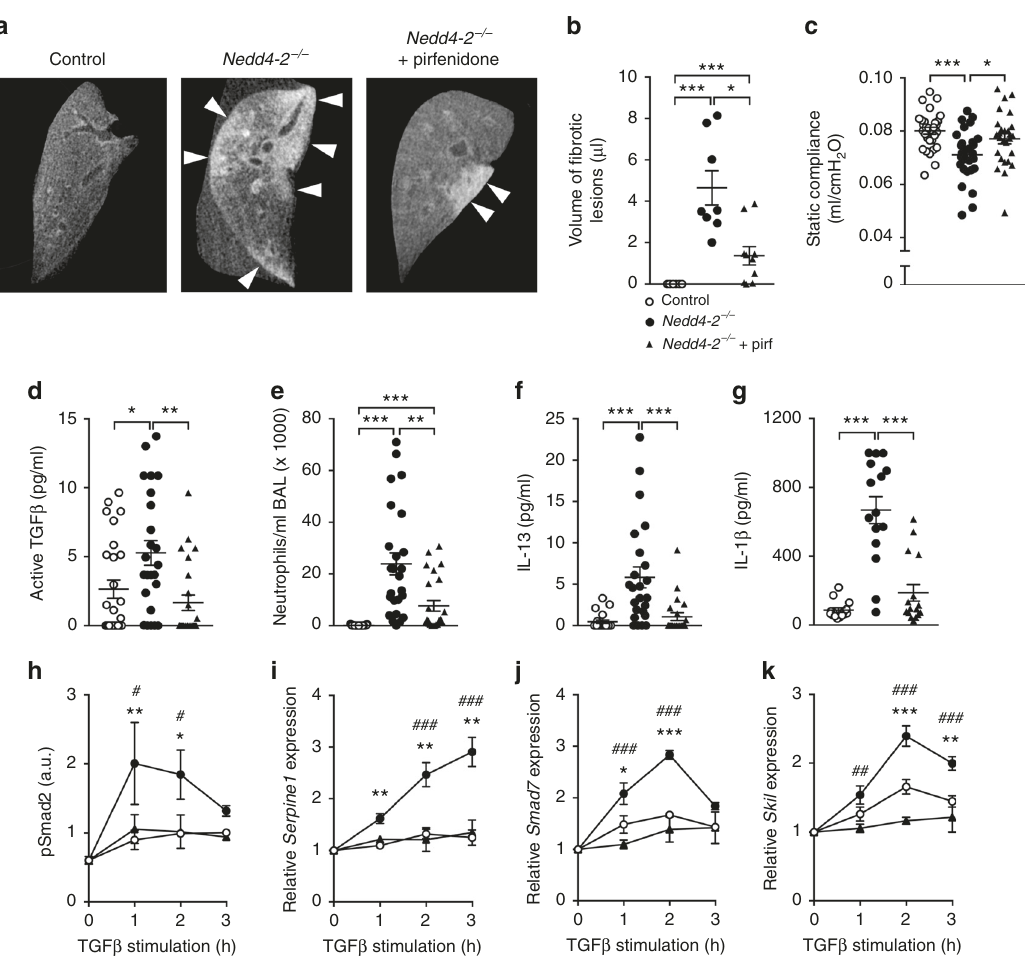
Fig. 8 Pirfenidone treatment reduces pulmonary fi brosis and in fl ammation in conditional Nedd4-2 − / − mice. a Representative micro-CT images of paraf fi n embedded lungs of 3-months doxycycline-induced conditional Nedd4-2 − / − and control mice treated with pirfenidone (pirf) or vehicle alone for one month. Fibrotic areas show patches of increased tissue density (white arrowheads) (control, n = 8; conditional Nedd4-2 − / − , n = 8; conditional Nedd4-2 − / − + pirf, n = 10). b Volumetric analysis of fi brotic regions in the three experimental groups (control, n = 8; conditional Nedd4-2 − / − , n = 8; conditional Nedd4- 2 − / − + pirf, n = 10). c , d Effect of pirfenidone treatment on static compliance (control, n = 30; conditional Nedd4-2 − / − , n = 28; conditional Nedd4-2 − / − + pirf, n = 27) ( c ) and on concentrations of active TGF β in lung homogenates (control, n = 27; conditional Nedd4-2 − / − , n = 24; conditional Nedd4-2 − / − + pirf, n = 24) ( d ). e – g Number of neutrophils (control, n = 29; conditional Nedd4-2 − / − , n = 25; conditional Nedd4-2 − / − + pirf, n = 25) ( e ) and concentration of IL-13 in bronchoalveolar lavage fl uid (control, n = 21; conditional Nedd4-2 − / − , n = 24; conditional Nedd4-2 − / − + pirf, n = 22) ( f ), and concentration of IL-1 β in lung homogenates (control, n = 15; conditional Nedd4-2 − / − , n = 15; conditional Nedd4-2 − / − + pirf, n = 16) ( g ) of conditional Nedd4-2 − / − and control mice treated with pirfenidone or vehicle alone. * P < 0.05, ** P < 0.01, *** P < 0.001. h – k Effect of pirfenidone on TGF β signaling in alveolar type 2 cells isolated from conditional Nedd4-2 − / − and control mice induced with doxycycline for 2 weeks that were pretreated with 1 ng/ml TGF β and analyzed for phosphorylated Smad2 (pSmad2) and transcript levels of TGF β -regulated genes. h Densitometric analysis of pSmad2 at baseline and after 1 – 3 h of TGF β stimulation. i – k mRNA levels of Serpine1 ( i ), Smad7 ( j ), and Skil ( k ) at ind i cated times after TGF β stimulation in the presence or absence of pirfenidone. ( n = 3 independent experiments). * P < 0.05, ** P < 0.01, *** P < 0.001 compared to control mice. # P < 0.05, ## P < 0.01, ### P < 0.001 compared to pirfenidone treated conditional Nedd4-2 − / − mice. Statistical analysis was performed with Kruskal wallis test and Mann – Whitney test corrected for multiple comparisons with Bonferroni method as post hoc test in b , d – g , one-way ANOVA with Tukey ’ s post hoc test in c and two-way ANOVA with Tukey ’ s post hoc test in h – k . Data are shown as mean ± S.E.M. Source data are provided in the Source Data fi found that conditional deletion of Nedd4-2 augmented TGF β signaling, which resulted in hyperresponsiveness of AT2 cells to TGF β stimulation, and increased expression of active TGF β and pro- fi brotic marker genes in the lung (Fig. 6). This effect is consistent with lack of Nedd4-2 mediated degradation of phos- phorylated Smad2/3 24 acting as important signal transducers that mediate a pro- fi brotic response. A central role of the TGF β /Smad signaling pathway in pulmonary fi brosis was demonstrated in mice de fi cient for Smad3 that were protected from bleomycin induced fi brosis 42 . These data support augmentation of TGF β / Smad signaling as an important intracellular defect contributing